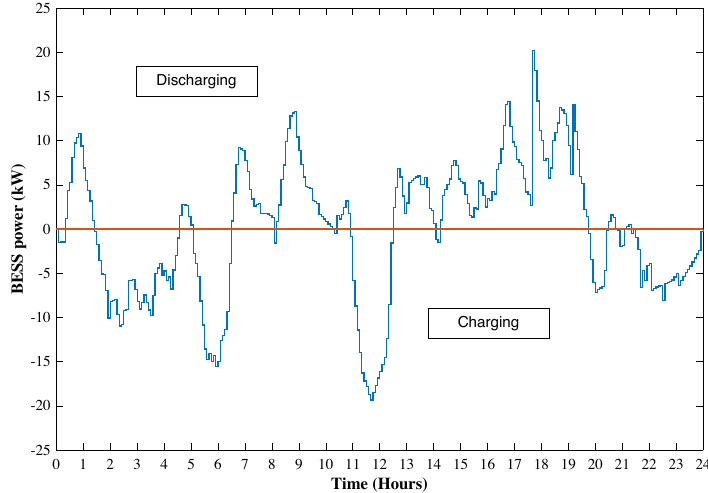
Figure 7. BESS − power for the case shown in Figure 6.